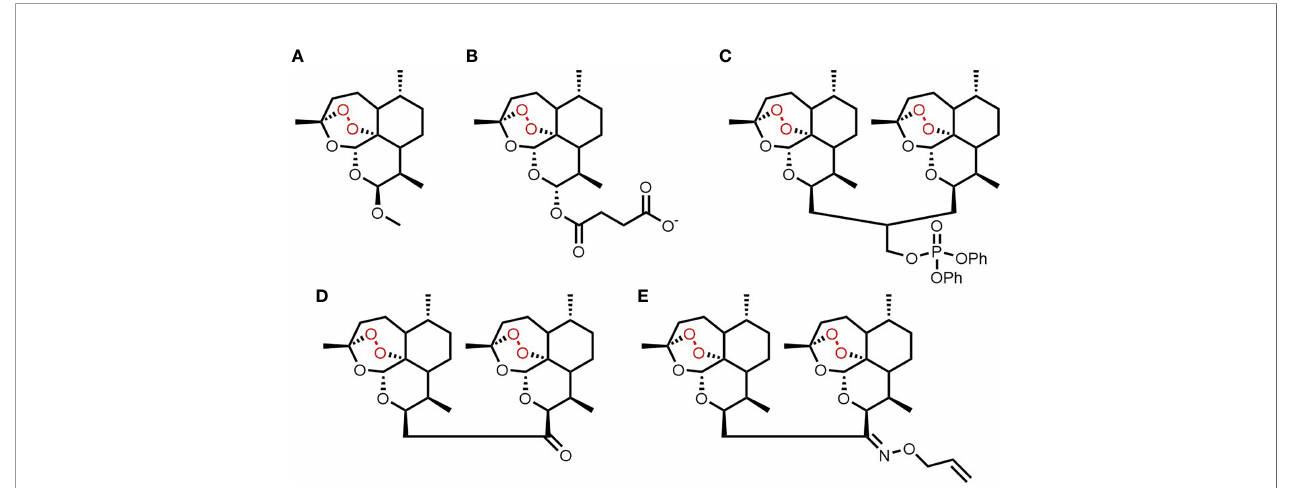
FIGURE 1 | Chemical structures of artemisinin (A) , artesunate (B) , ART838 (C) , ART576 (D) and ART631 (E)